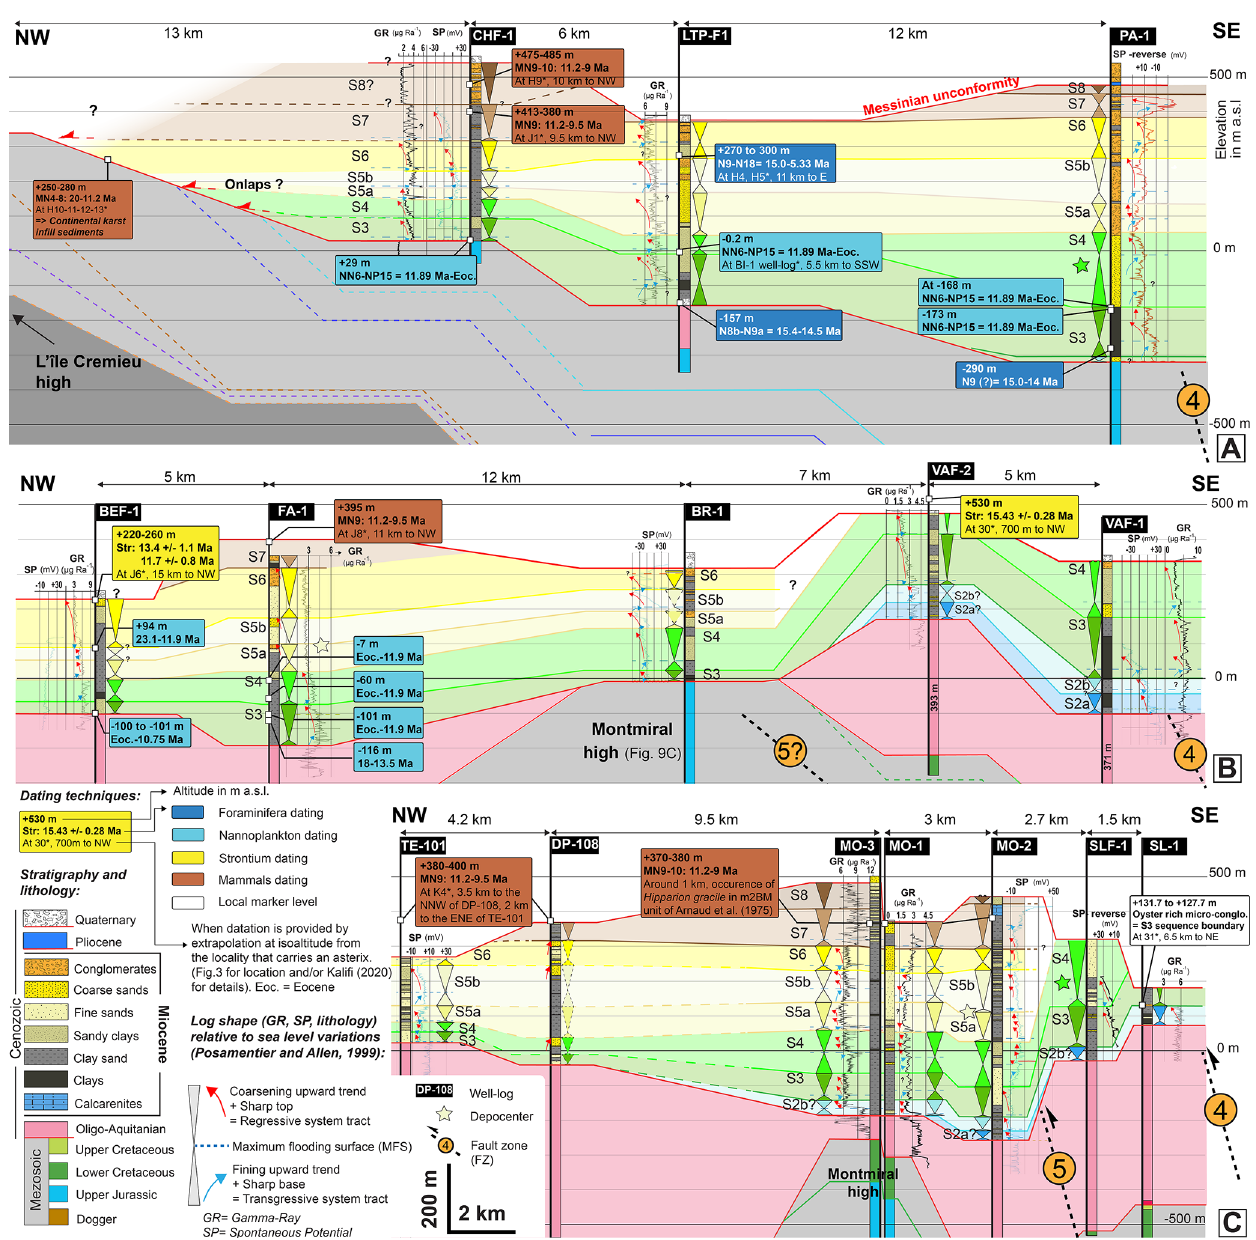
Figure 15. Spatiotemporal distribution of Miocene molasse deposits along SE–NW transects of the Bas-Dauphiné basin. Correlations are proposed based on sequence stratigraphy interpretations using stacking pattern methodology on SP (spontaneous potential), GR (gamma ray), and lithological data from well logs. See Fig. 3 for the location of